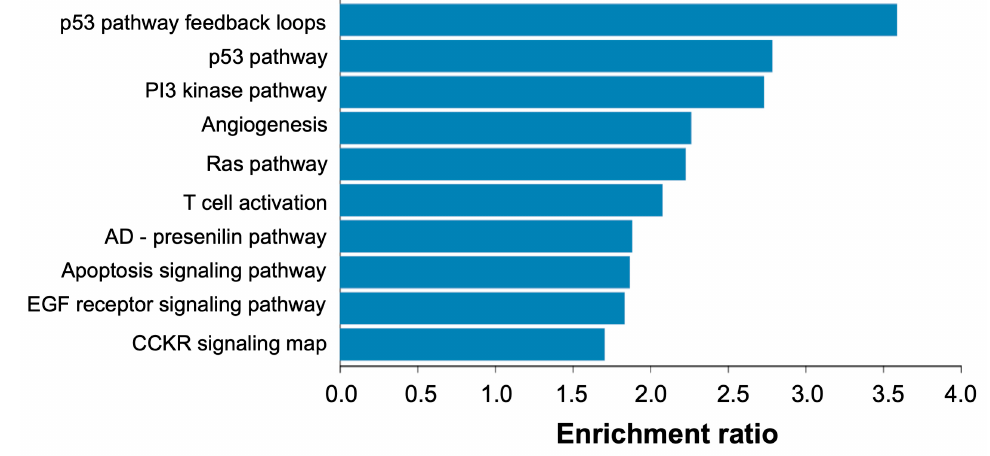
Figure 10. Pathway over-representation analysis of candidate miRNA target genes relevant to ovarian cancer. Analysis was performed via Webgestalt (http://www.webgestalt.org/ (accessed on 7 November 2022)) against Panther pathways and using whole human genome as background. The x-axis refers to the enrichment ratio for each pathway (all pathways were significantly enriched at FDR < 5%).